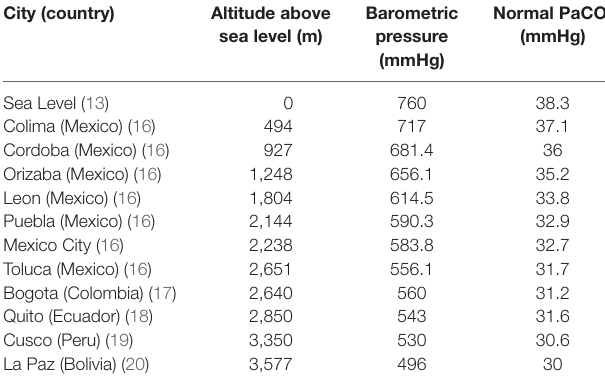
TABLe 1 | Modification of normal PaCO 2 values according to changes in central temperature ([ref]15).